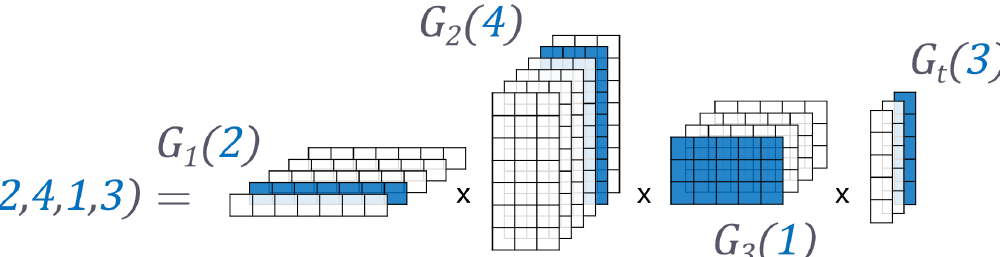
Figure 1. Illustration of the evaluation of one element of a fourth-order tensor (with four indices) having a tensor train decomposition. G 1 , G 2 , G 3 , G t are the tensor carriages of this decomposition. T ( 2,4,1,3 ) ∈ R is obtained by the product of one row vector G and one column vector G t ( 3 ) . The dimensions of these matrices are respectively 1 × 7, 7 × 3, 3 × 5, and 5 × 1. G 1 ( 2 ) , G 2 ( 4 ) , G 3 ( 1 ) , and G t ( 3 ) are the extraction of one layer (identified by a darker shade) in the tensor G 1 , G 2 , G 3 , G t ,